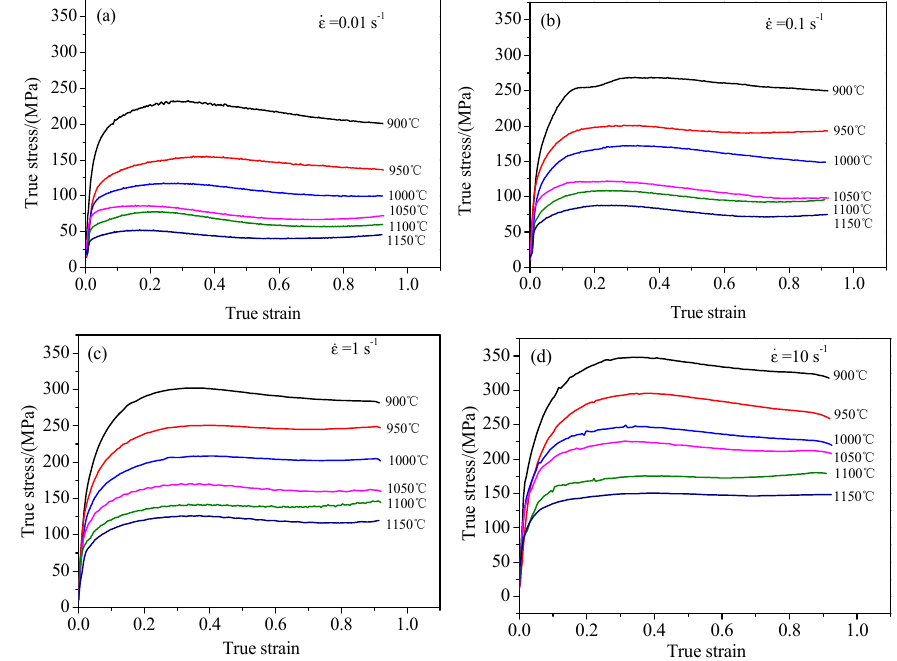
Figure 1. Stress-strain curves for the H13-mod steel deformed at strain rates of ( a ) 0.01 s − 1 ; ( b ) 0.1 s − 1 ; ( c ) 1 s − 1 and ( d ) 10 s − 1 .